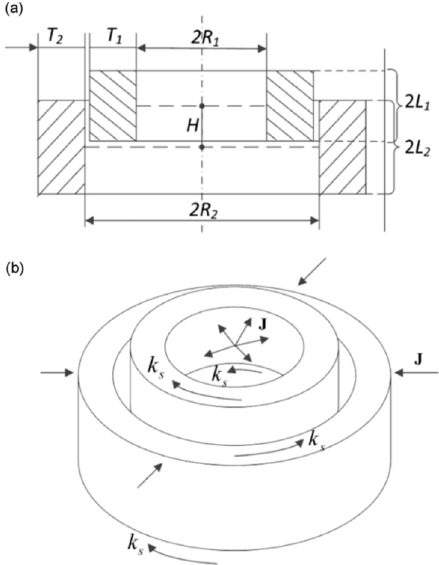
Figure 10. Schematic diagram of the first proposed negative-stiffness magnetic spring (NSMS) vibration isolator: ( a ) Geometric parameters of the first NSMS vibration isolator and ( b ) distribution of equivalent current on the first proposed NSMS vibration isolator [60].